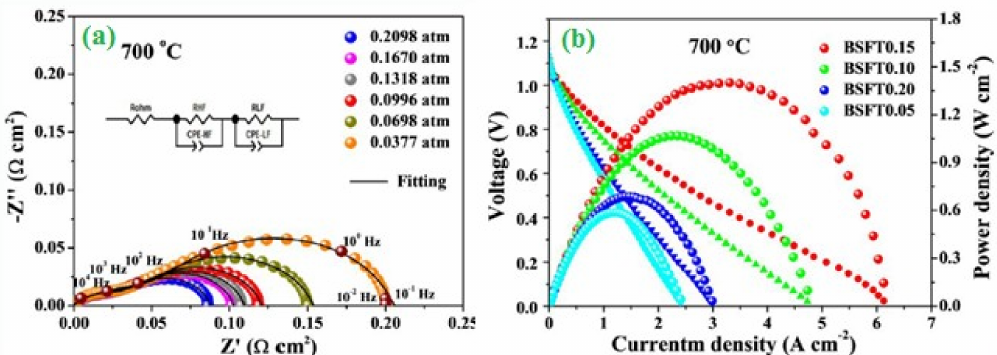
Figure 7. ( a ) The electrochemical impedance spectra of Bi 0.5 Sr 0.5 Fe 1 − x Ti x O 3 − δ (BSFT0.15) cathode ( b ) I – V and I – P curves of the cells with BSFT x cathodes at 700 ◦ C. Reprinted with permission from [89]. Copyright (2019), American Chemical